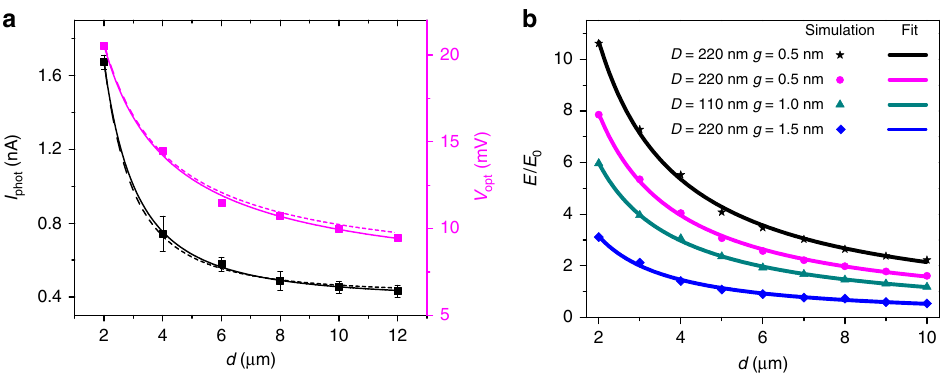
Fig. 4 Characteristics of the optical wireless power transfer. a Dependence of I phot and V opt on the distance between the illuminated optical antenna and the rectenna for an excitation intensity of 352 kW cm − 2 (black and magenta squares, respectively). The solid black and magenta lines indicate the best fi ts obtained by using a generic power law function ( α d b + c ). For comparison, d − 2 and d − 1 dependences for I phot and V opt are also shown as black and magenta dashed lines, respectively. b Simulated results of the electric fi eld amplitude at the feed-gap vs d for different combinations of gap widths and antenna diameters. The power law fi ts (solid lines) always converge to an exponent close to − 1. The fi eld amplitude decreases with the gap width as well as for an off-resonant antenna ( D = 110 nm)